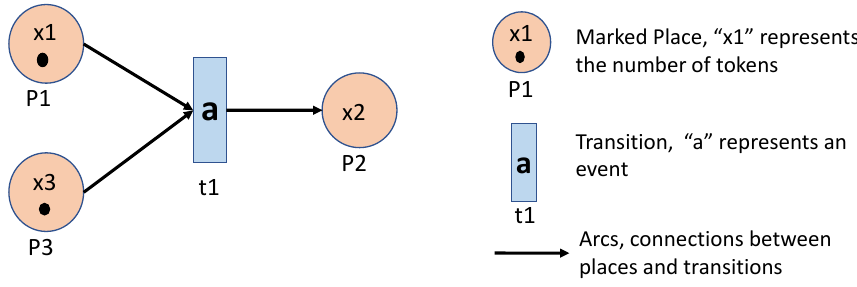
Figure 3. A Petri Net Graph